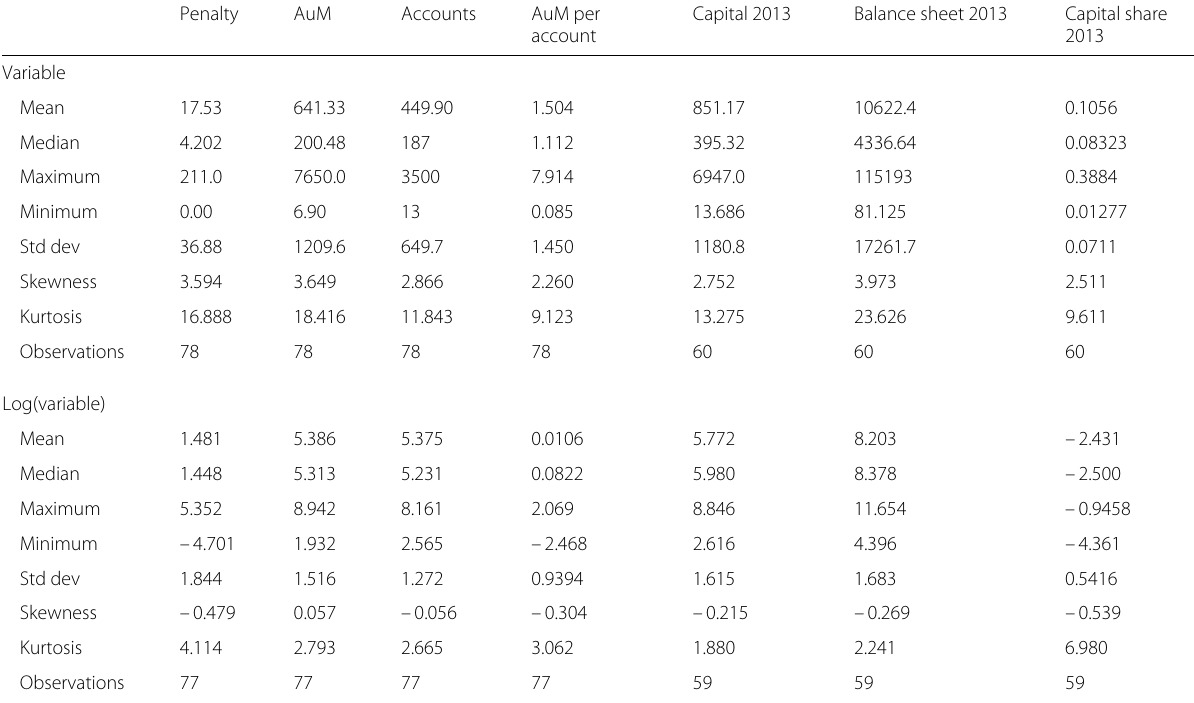
Table 2 Some descriptive statistics (penalties and AuM in million USD; capital and balance sheet in million